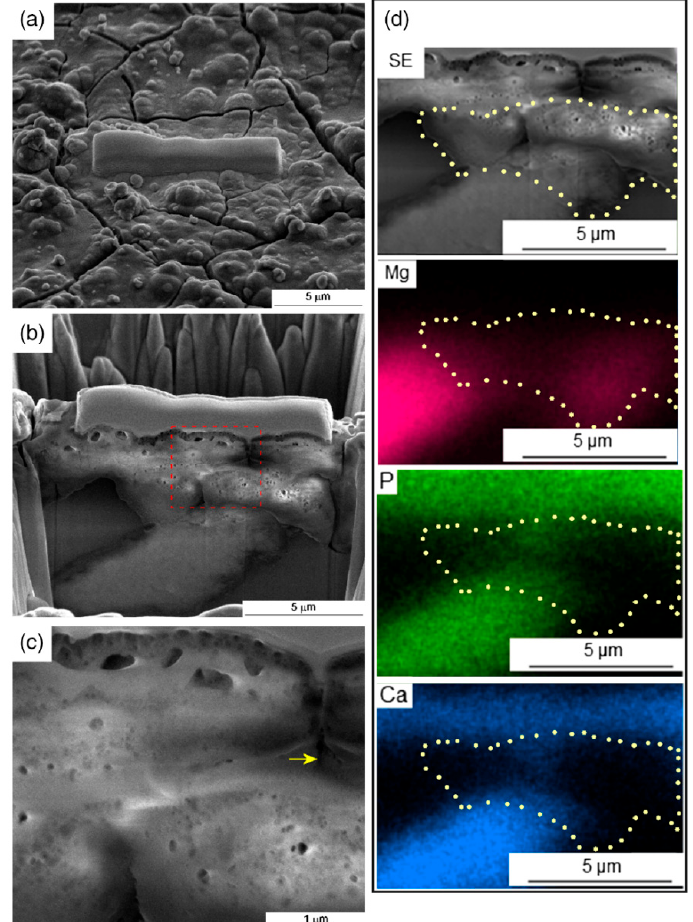
Figure 14. Elemental composition distribution along the depth of an Mg–HA composite produced via HPT and subjected via immersion in Hank’s solution [121].